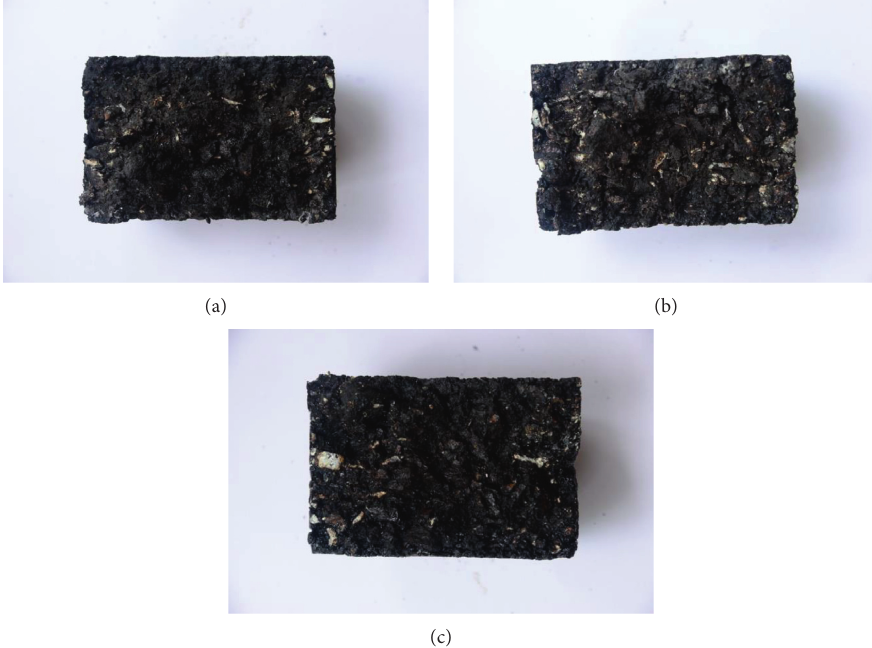
Figure 6: Sample specimen of (a) Dry-HP180, (b) 1FT-HO180, (c)